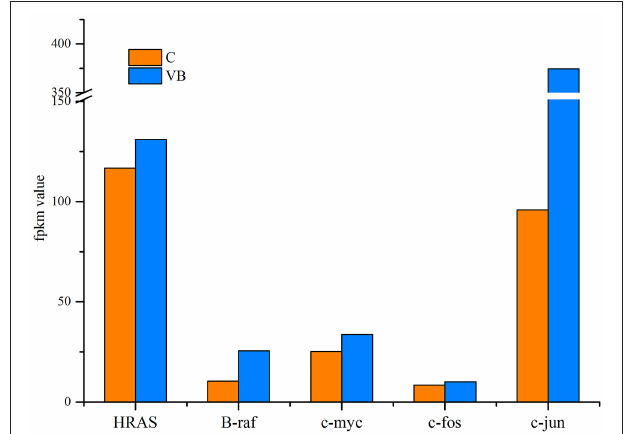
FIGURE 10 | Expression level of oncogenes.